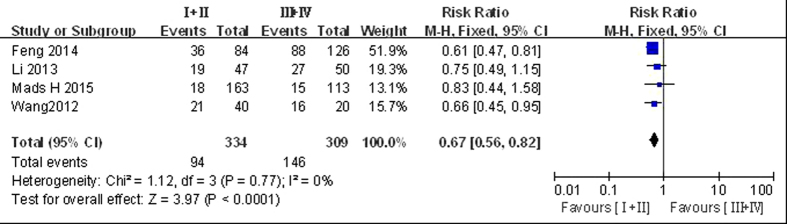
Forest plot of risk ratios of legumain overexpression in I–II vs III–IV groups.